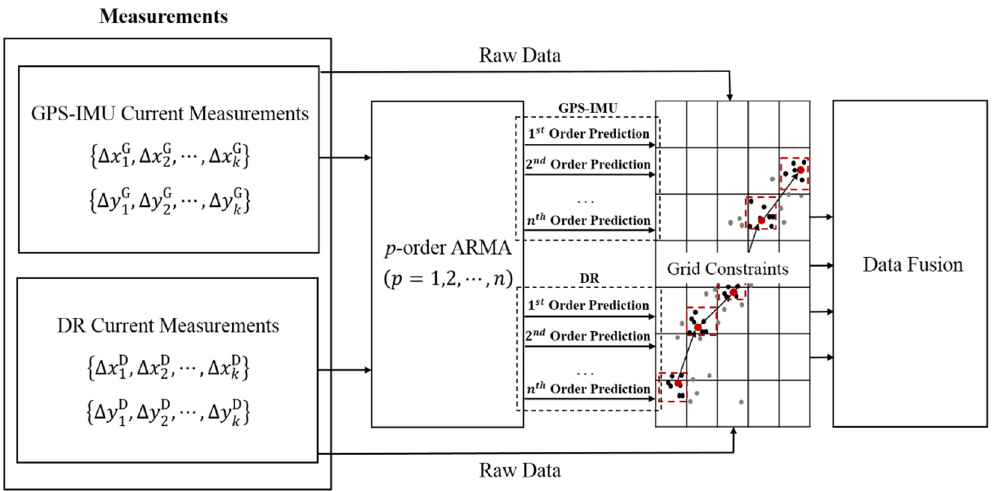
Figure 1. The flowchart of the proposed data fusion method.